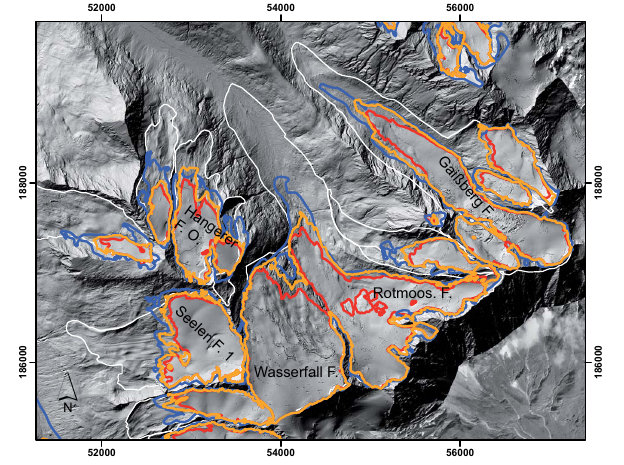
Figure 8. Resulting LIA glacier areas (white) with several mod- ern glaciers contributing to the LIA Rotmoos Ferner and LIA Gaißbergferner (all glacier names: see Fig. 2).